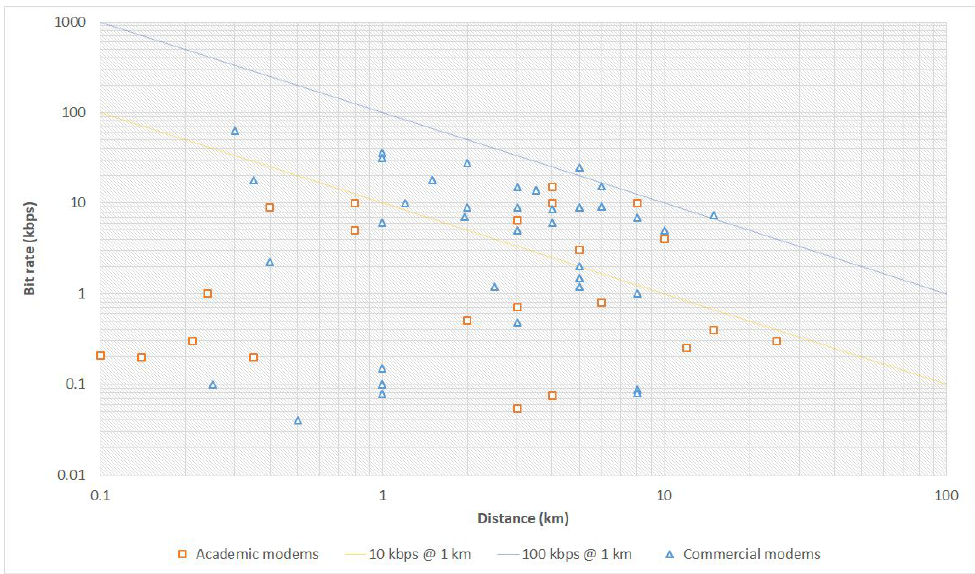
Figure 1. Performance of academic and commercial